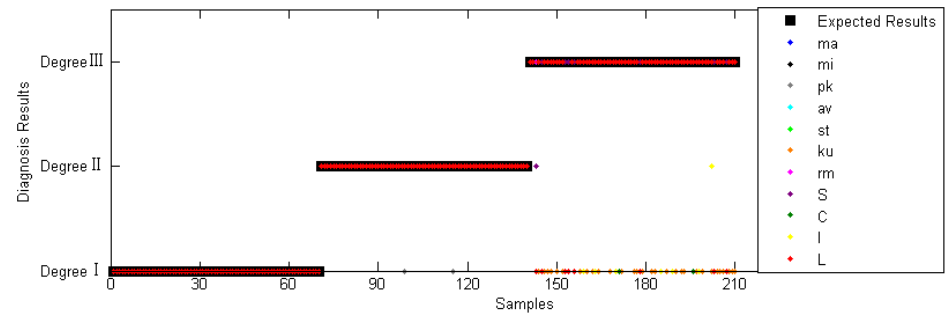
Figure 10. Diagnosis results of inner race fault severity estimation based on the BPNN_IR network.